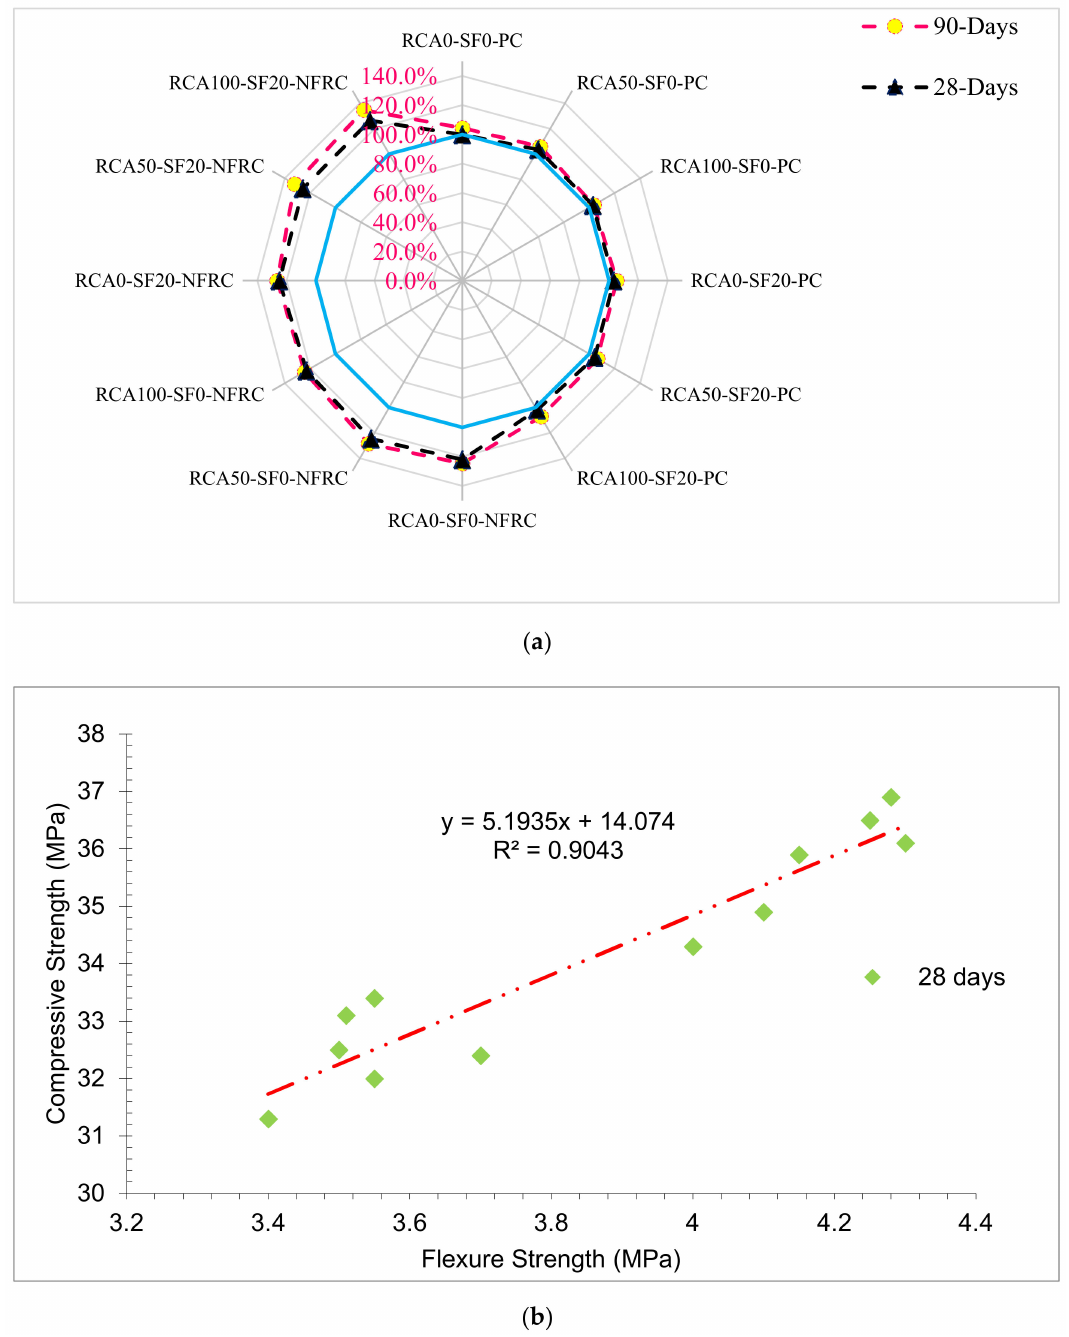
Figure 6. ( a ) Relative Analysis of Flexure Strength, ( b ) Correlation between Compressive and Flexure